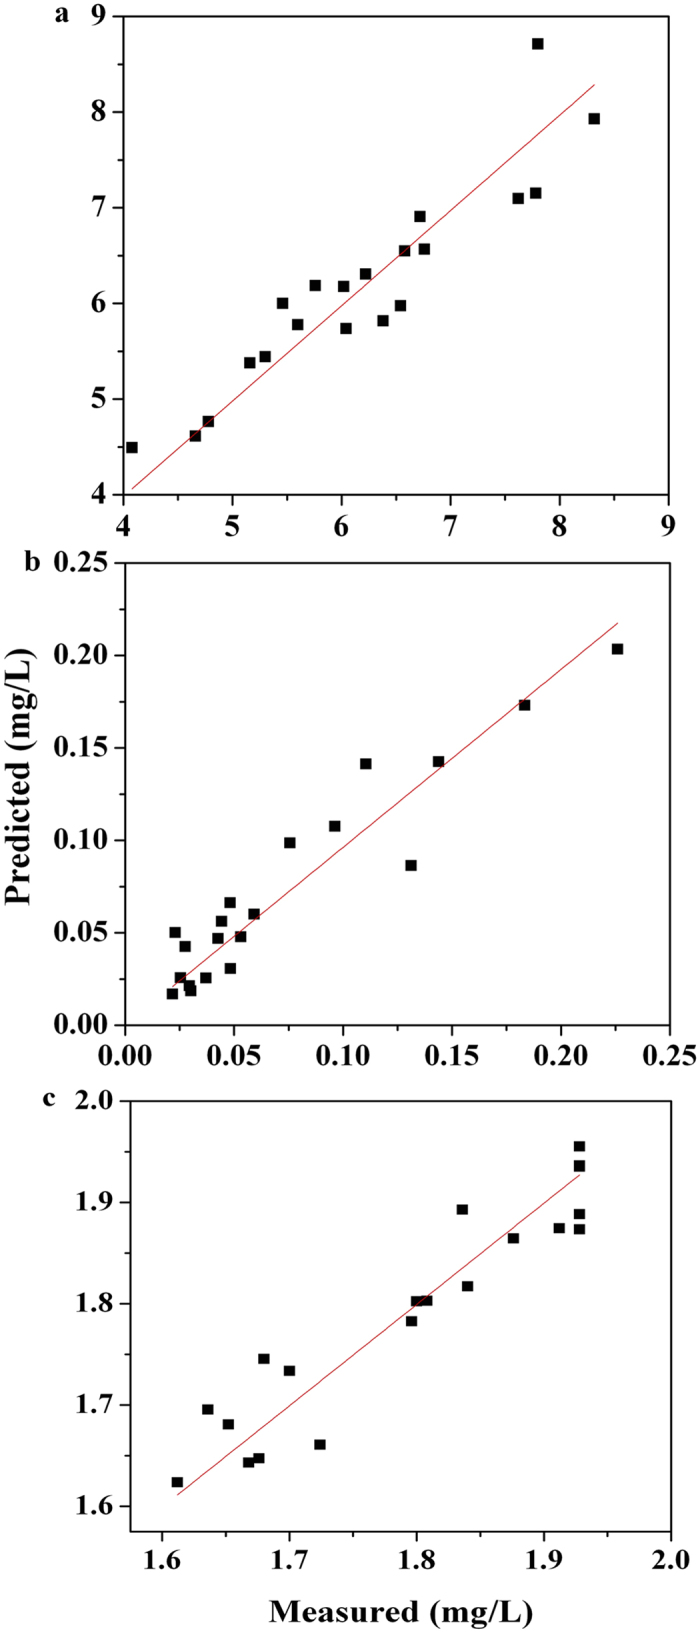
Relationship between the predicted and measured (a) residual TOC; (b) residual PO43−-P; and (c) residual NH4+-N.